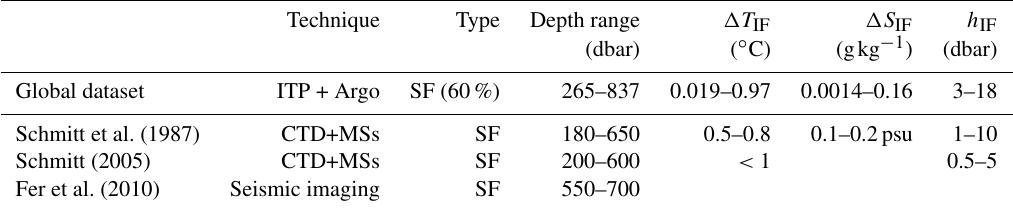
Table 5. As Table 3, but for the western tropical North Atlantic Ocean (10–15 ◦ N, 53–58 ◦